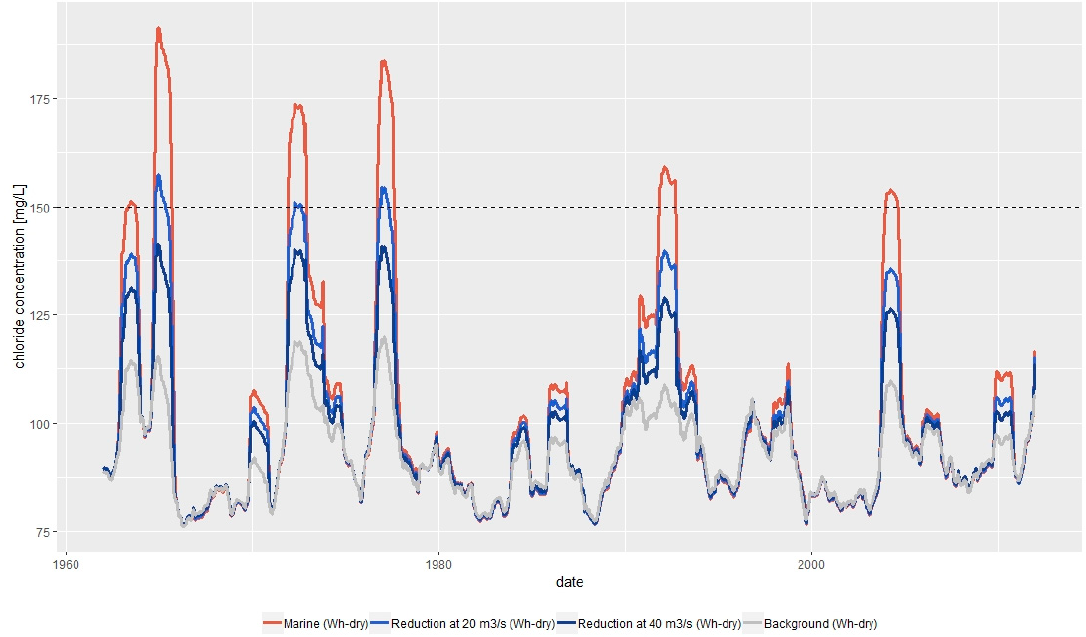
Figure 10. Effect of maintaining a minimum upstream discharge of 20 and 40 m 3 /s on the 365-day moving average chloride concentration at Streefkerk